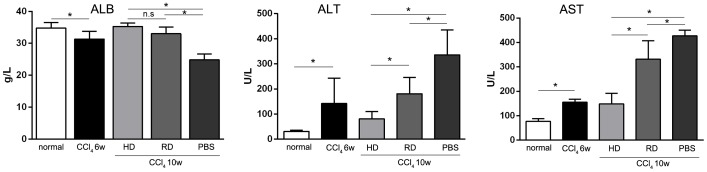
Protective effect of cell transplantation in liver function.Blood samples of normal and experimental rats were collected and serum levels of albumin (ALB), glutamic oxalacetic transaminase (AST) and glutamic pyruvic transaminase (ALT) were tested before (CCl4 6w) and after (CCl4 10w) cell transplantation. (n = 6/group; *p<0.05).